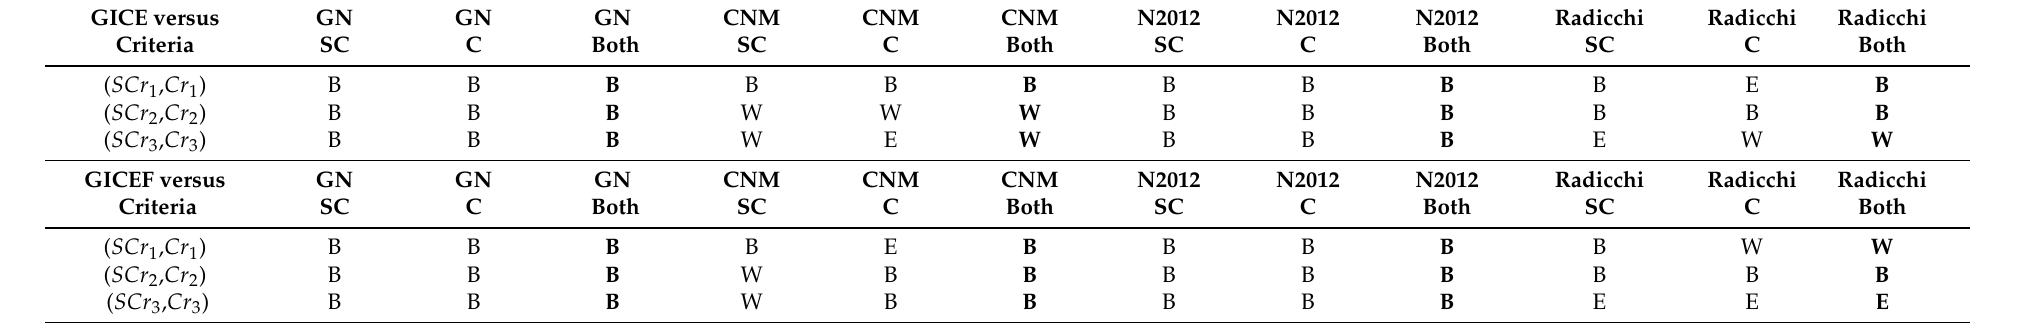
Table 9. Comparison between GICE and GICEF algorithms versus GN, CNM, N2012 and Radicchi algorithms from a Modularity and Homogeneity point of view in the criteria Cr 1 , Cr 2 , Cr 3 and SCr 1 , SCr 2 , SCr 3 for the authors network. Letter B represent that our algorithm present better performance in this criteria, W worst and E represent that the difference is not